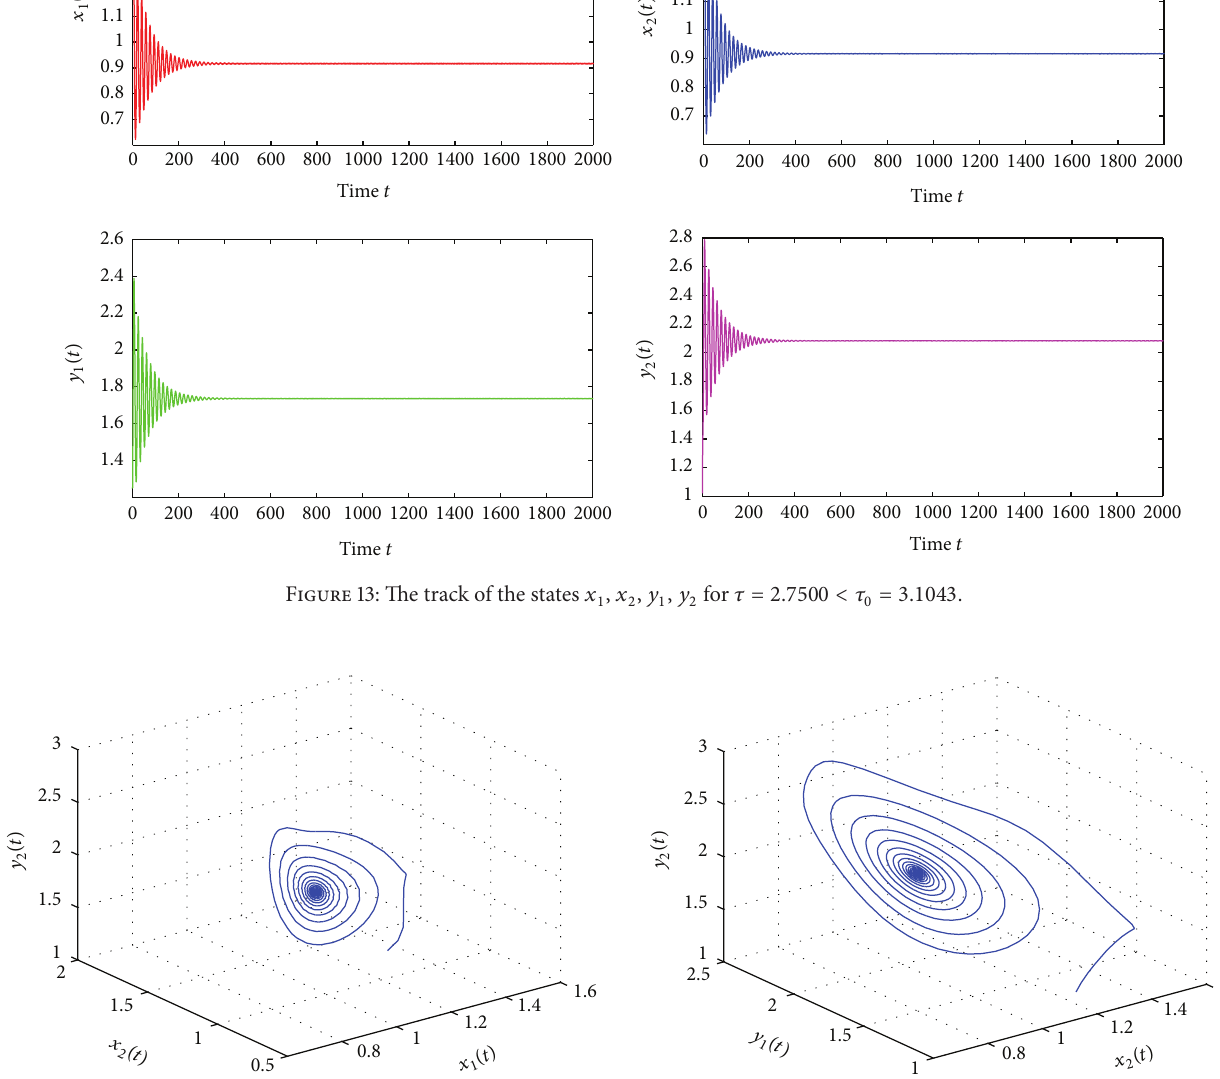
Figure 15: The phase plot of the states 𝑥 2 , 𝑦 1 , 𝑦 2 for 𝜏 = 2.7500 < = 3.1043 𝜏 0